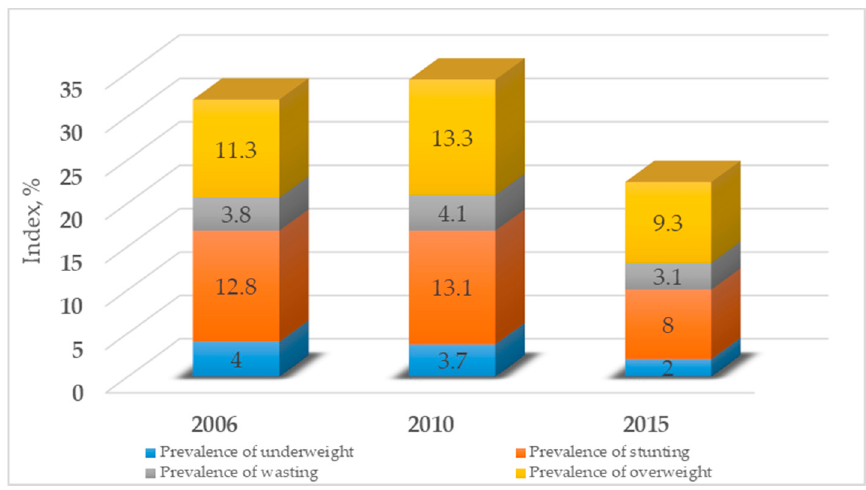
Figure 1. Nutritional status of Children under Five Years of Age. Source: Bureau of National Statistics of the Agency for Strategic Planning and Reforms of the Republic of Kazakhstan. Available online: https://stat.gov.kz/ (accessed on 26 May 2021).